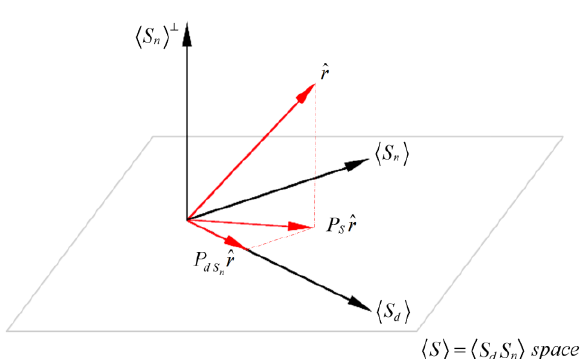
Figure 1. The concept of the utilized subspace projections.